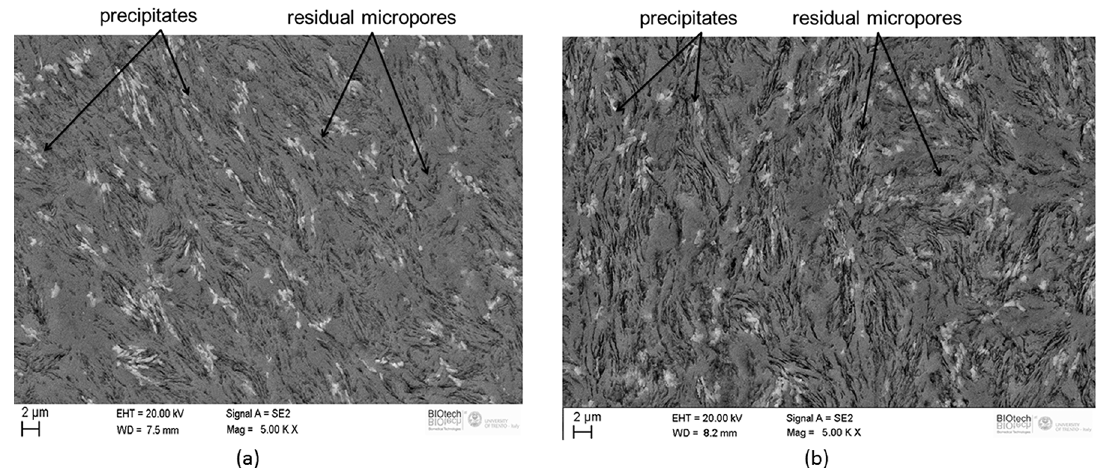
Figure 8. SEM images of samples cryomilled for 8 h, degassed for 20 h at (a) 250 °C and (b) 350 °C, and then sintered. Table 5. Hardness and microhardness of the atomized and 8 h milled and sintered samples. Hardness Degassing (HB